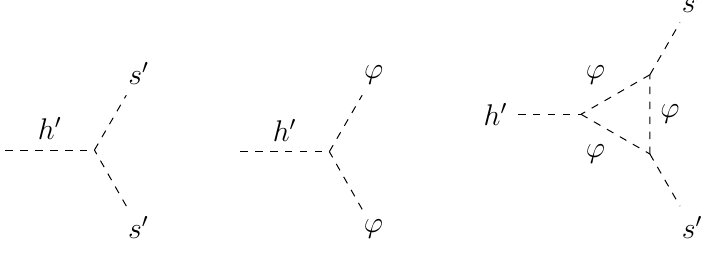
Figure 4 . The tree-level invisible Higgs decay h 0 → s 0 s 0 is dynamically forbidden. The tree-level Figure 6: The tree-level invisible Higgs decay is dynamically forbidden. h 0 → ϕϕ and the one-loop h 0 → s 0 s 0 invisible Higgs decays are not allowed kinematically. The tree-level and the one-loop allowed kinematically. magnetic moment in eq. (3.7) and will show in section 4 that the model easily accommodates this